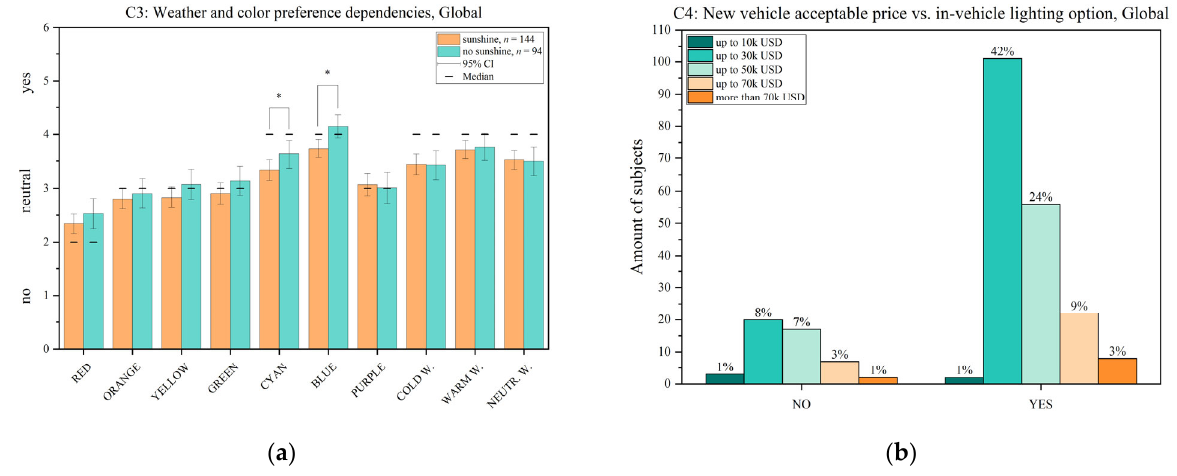
Figure 12. ( a ) Global relations between weather and color preferences; ( b ) expected vehicle price with in ‐ vehicle lighting options. Statistical evaluations with significances p < 0.05 marked with *.